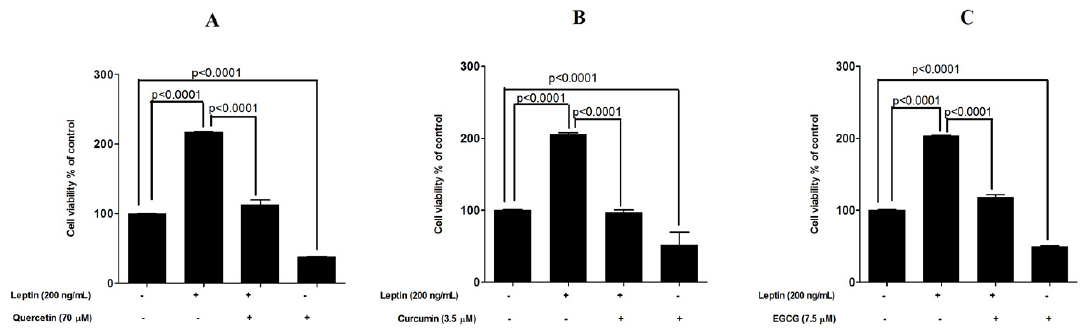
Figure 3. Protective effects exerted by ( A ) quercetin ( B ) curcumin and ( C ) EGCG in leptin-stimulated MCF-7 breast cancer cells examined by flurometric assay. *** p < 0.0001 compared with leptin-stimulated cells by one way ANOVA with Bonferroni test for selected pairs of columns.